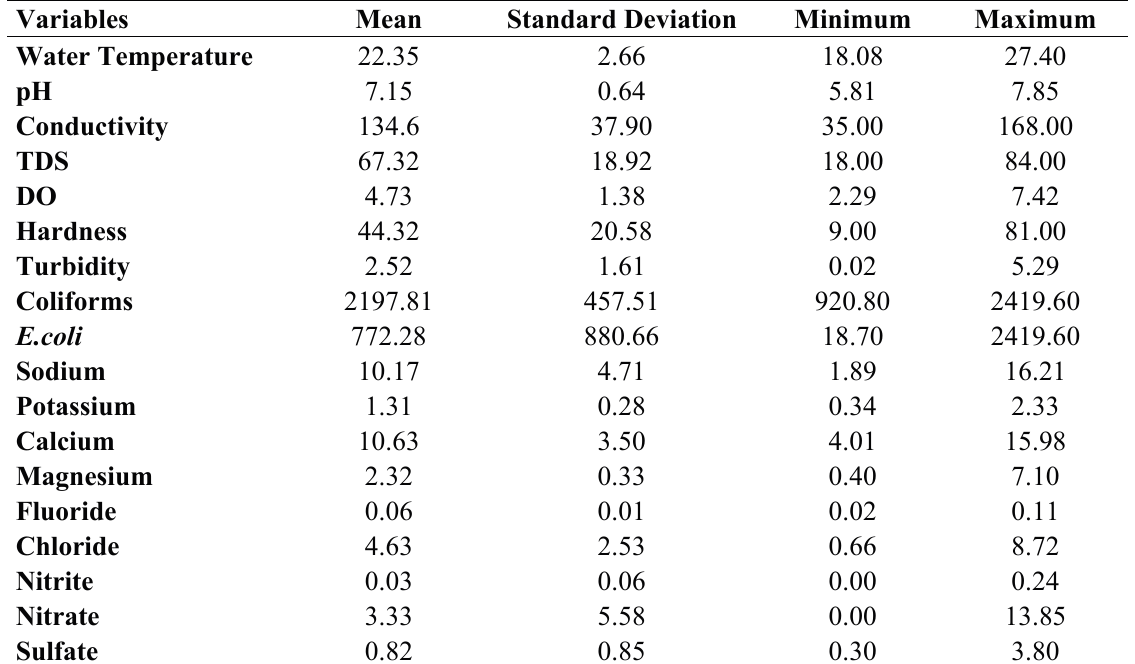
Table 4. Descriptive statistics attributed to physical, chemical and biological